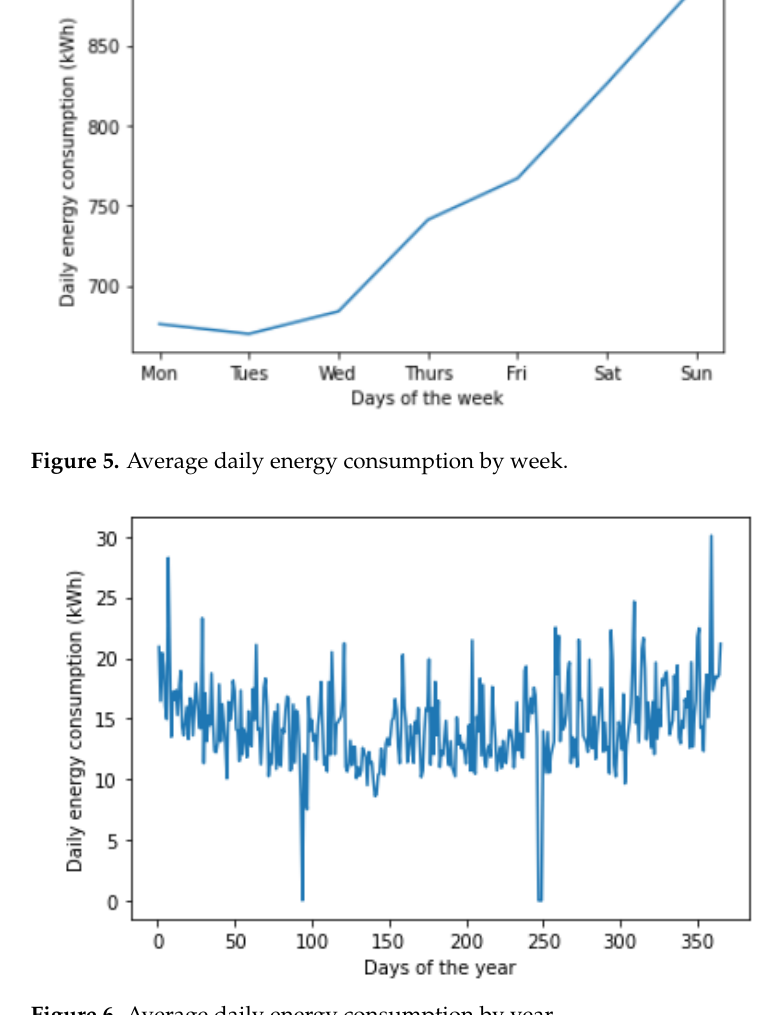
Figure 6. Average daily energy consumption by